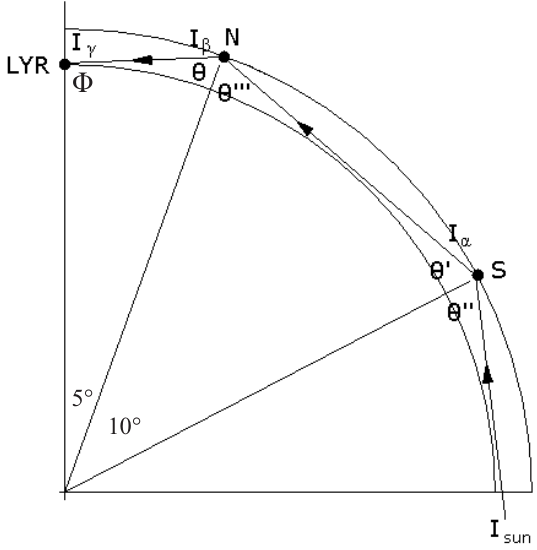
Fig. 7. Schematic showing the path taken by one ray in the model. Sunlight is scattered from the southern PSC (S) towards the north- ern PSC (N). The light is scattered at the northern PSC into the field of view of instrumentation at Longyearbyen (LYR). The an- gles, 2,2 0 ,2 00 ,2 000 and 8 indicate the scattering angles used in Eqs. (1), (2) and (3). The 5 ◦ and 10 ◦ indicate the maximum angu- lar distance a given cloud can be from the Earth’s tangent point and another PSC